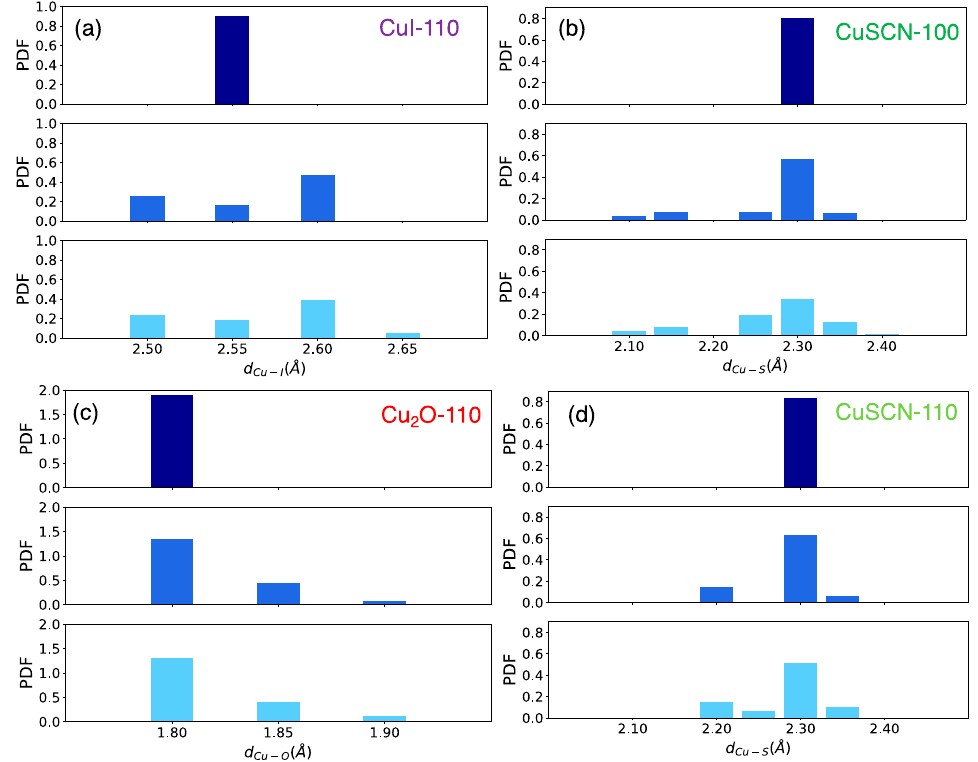
Figure 4. Side views of the pristine slab models shown before (left) and after (right) the structural relaxation for the (110) CuI slab ( a ), the (100) and the (110) CuSCN slabs ( b , c ) and the √3 (cid:3400) √3𝑅(cid:4666)30°(cid:4667) (111) Cu 2 O surface ( d ). Top view of the topmost layer of Cu 2 O slab before (left) and after (right) relaxation ( e ). None of the structures present Cu vacancies in the atomic arrangement.